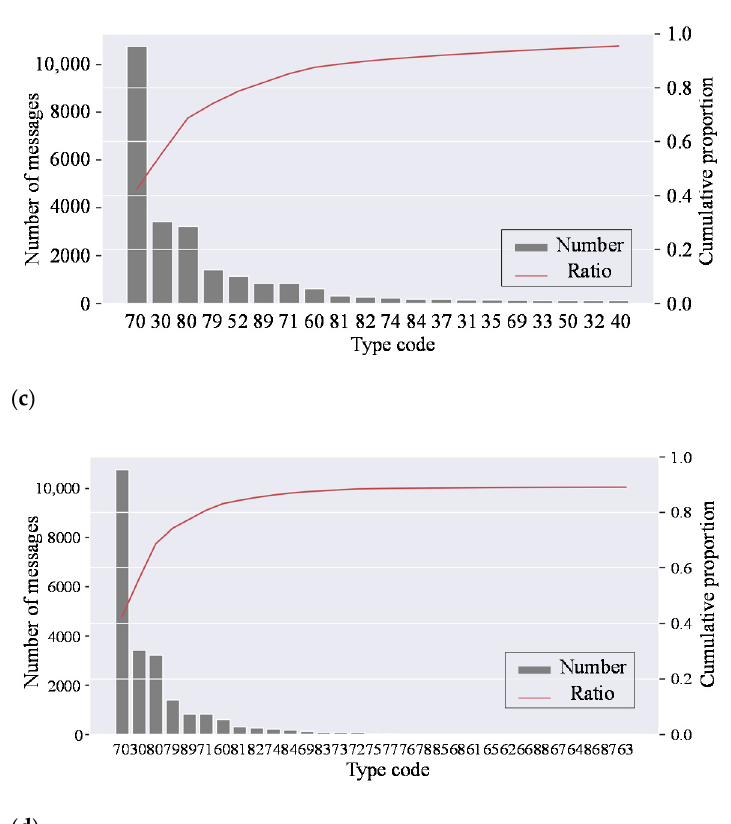
Figure 5. ( a ) Number and cumulative proportion of the top 20 ships (counted by message quantity); ( b ) Number and cumulative proportion of four types of ships (counted by message quantity); ( c ) Number and cumulative proportion of the top 20 ships (counted by MMSI quantity); ( d ) Number and cumulative proportion of four types of ships (counted by MMSI